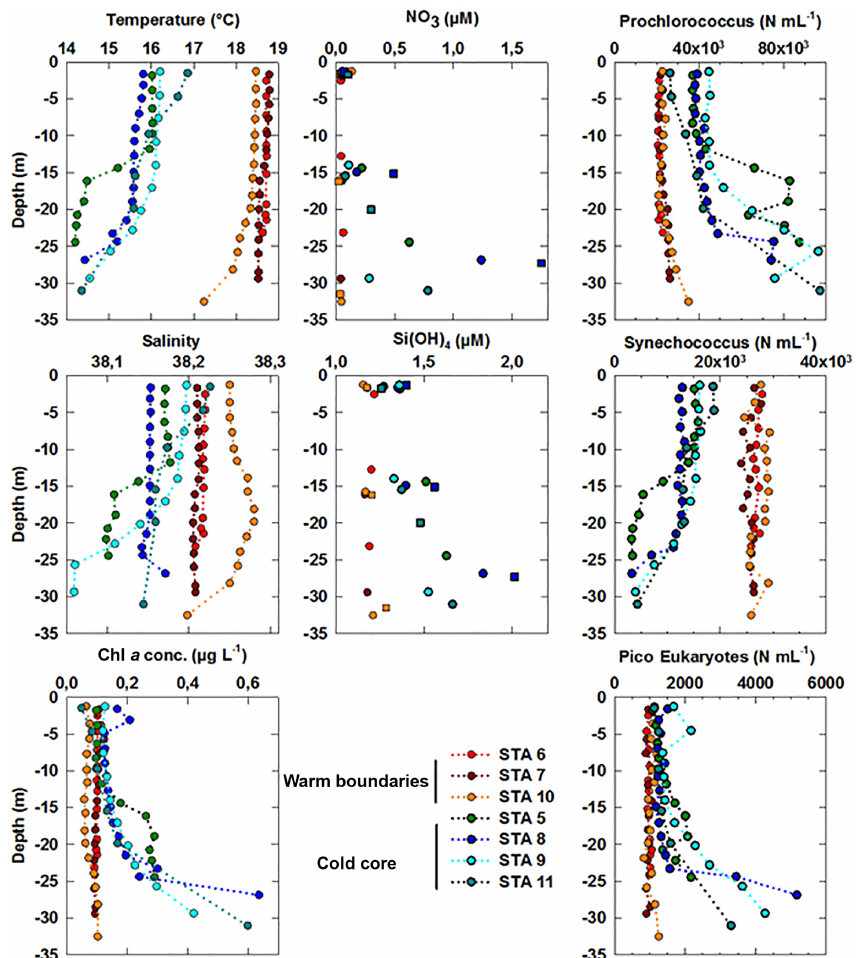
Figure 8. Vertical profiles of temperature (in ◦ C), salinity and Chl a concentrations (in µgdm − 3 ) obtained from the CTD fluorimeter after conversion at the depths where vertical high-resolution sampling was acquired for benchtop flow cytometry analysis using the PASTIS_HVR system. Abundances of Prochlorococcus , Synechococcus and picoeukaryote (PicoE + PicoHighFLR + PicoHighFLO) groups are expressed in cellscm − 3 . Nutrients were sampled at a different resolution using both the PASTIS_HVR system (circles) and the CTD rosette (squares). Stations performed in cold core surface waters are represented by blue-green colors and those performed in warm boundary surface waters by red-orange